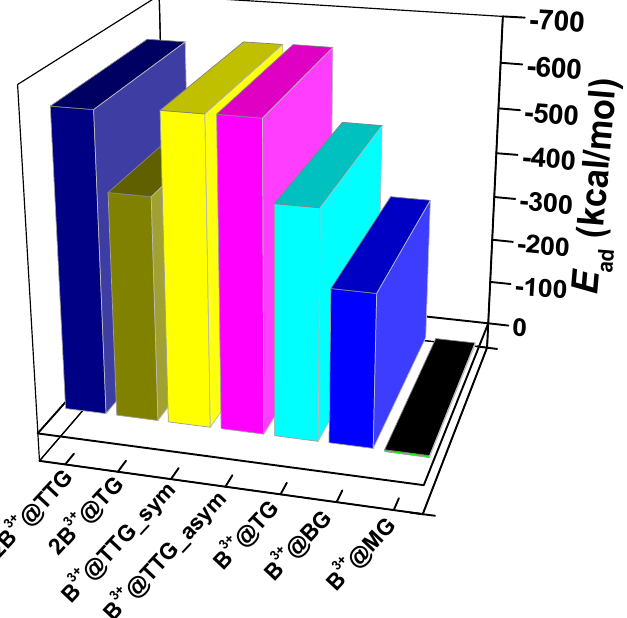
Figure 5. Adsorption energies (E ad ) of B 3+ ions on the seven studied systems including B 3+ @MG, B 3+ @BG, B 3+ @TG, B 3+ @TTG–asym, B 3+ @TTG–sym, 2B@TG, and 2 B 3+ @TTG.